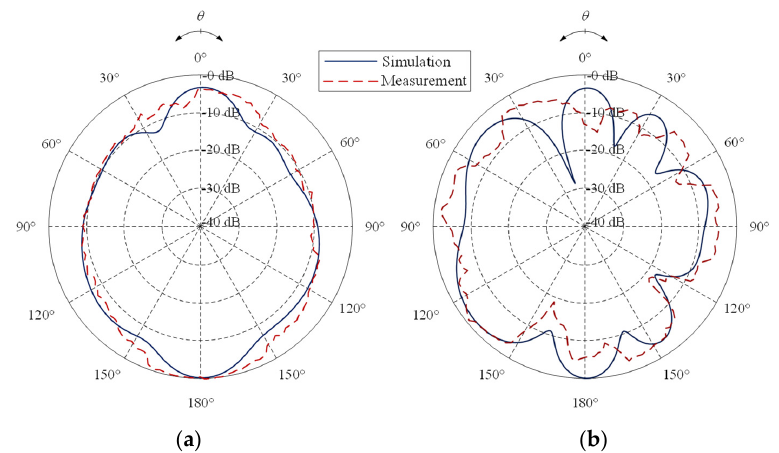
Figure 13. Simulated and measured radiation pattern at 15.5 GHz: ( a ) xz -plane and ( b ) yz -plane.